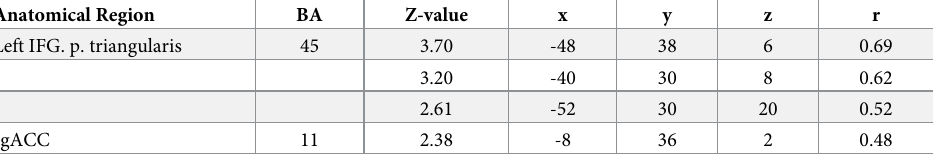
BA = Brodmann area: r = Pearson correlation coefficient: The correlations with the peak voxels are significant for p < .05